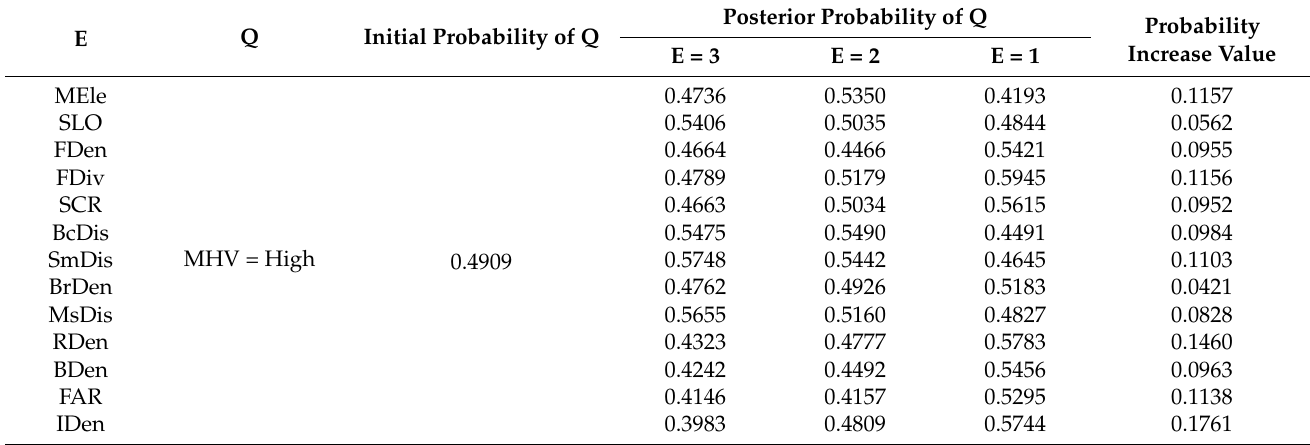
Table 6. Extent of influence of evidence variables on street dynamics.